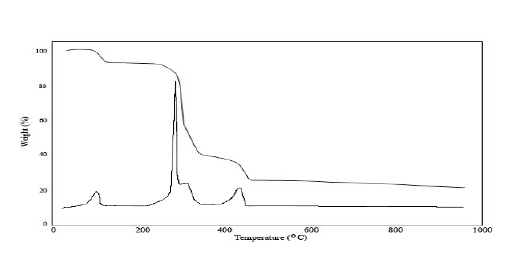
Figure 3. TG and DTA curves of Cu